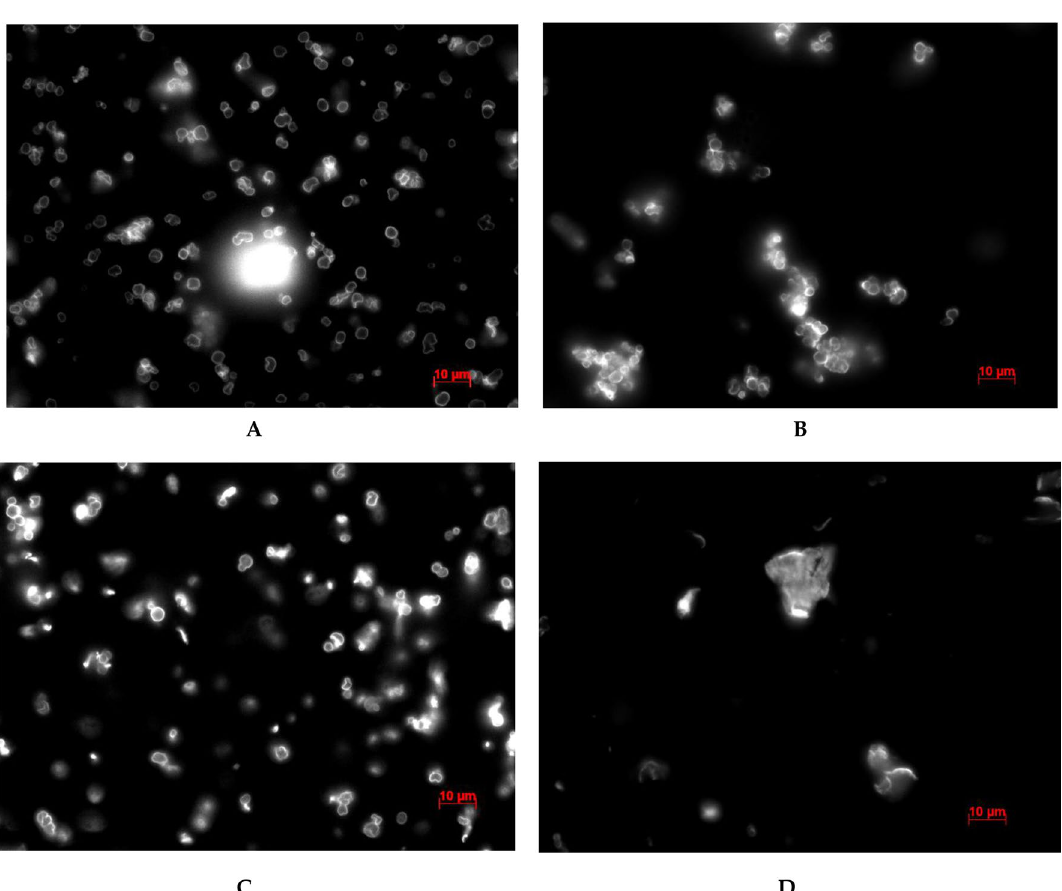
Figure 3. Image of polyelectrolyte microcapsules in 100 μg/ml ( A ) and 3000 μg/ml ( B ) SDS solution after 24 h of incubation.